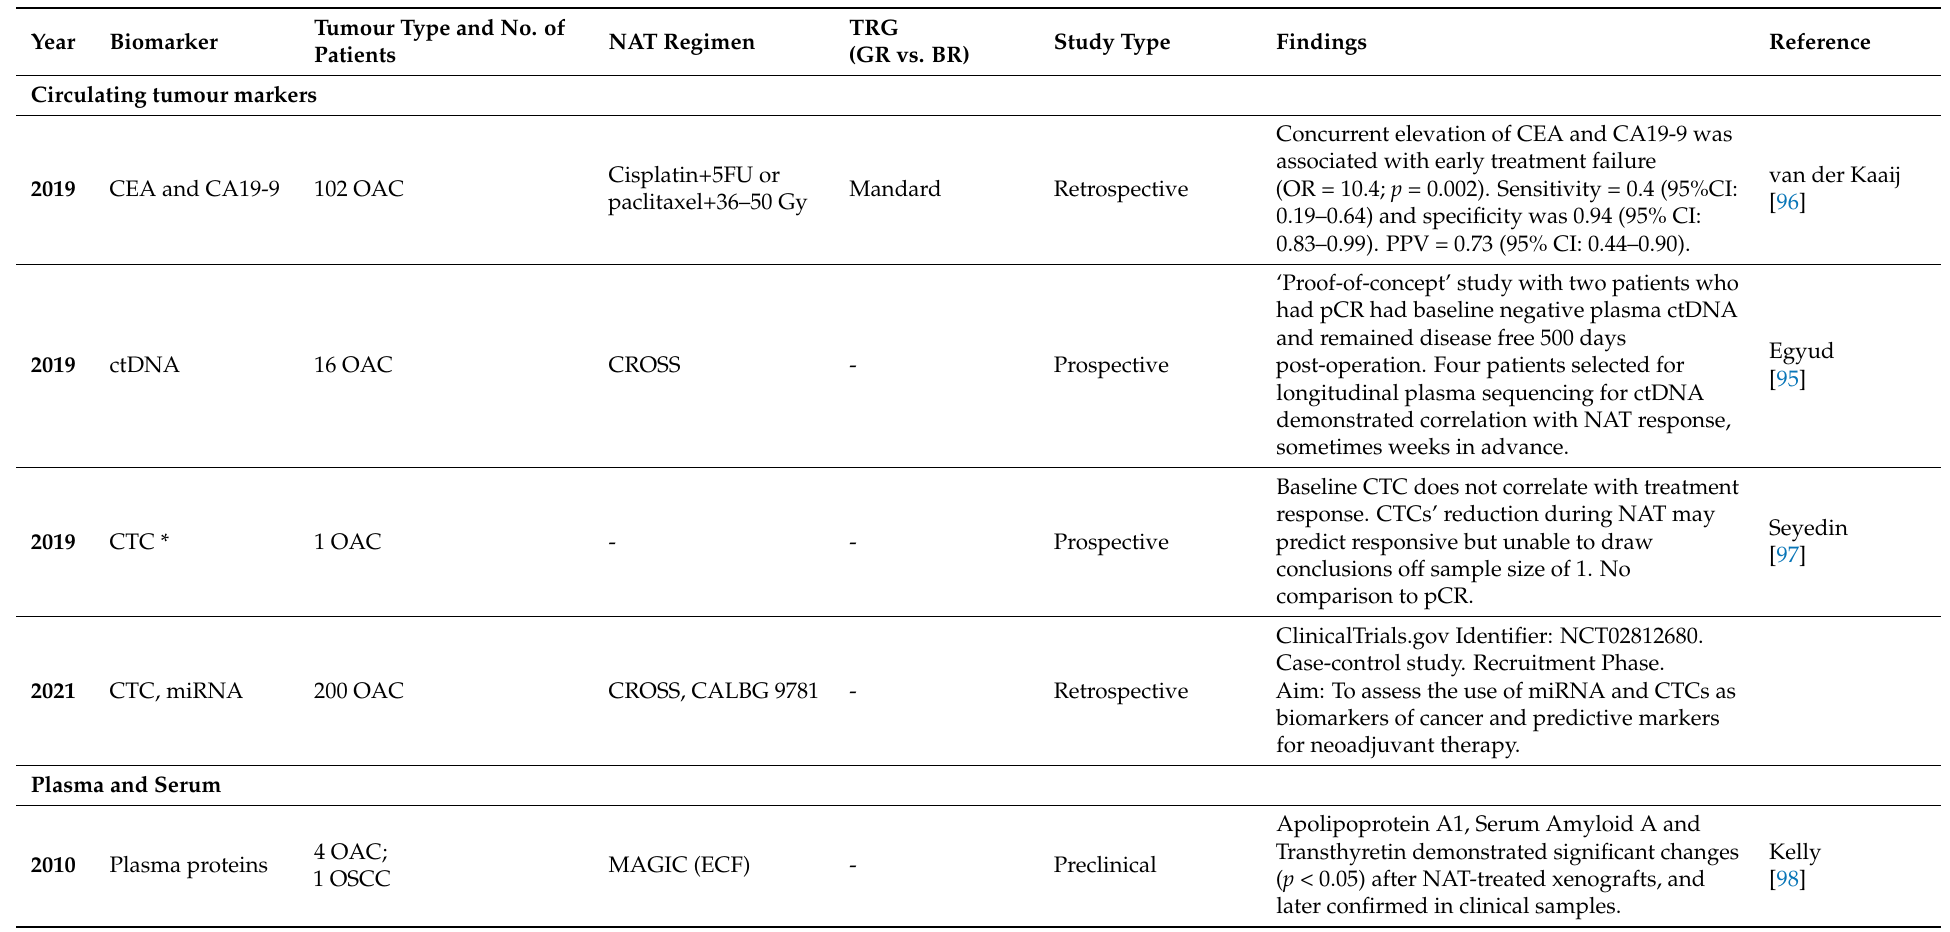
Table A6. Blood and Serum